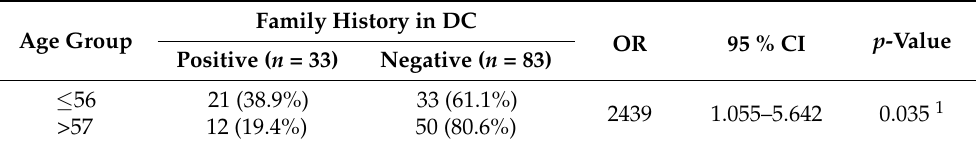
Table 6. The association between the previous onset of the Dupuytren’s contracture and positive family history of the disease.